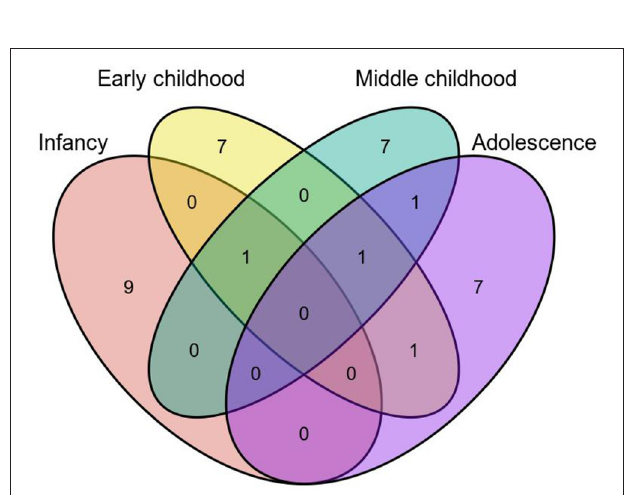
FIGURE 5 | Intersection of top 30 intestinal microbiota in abundance based on age